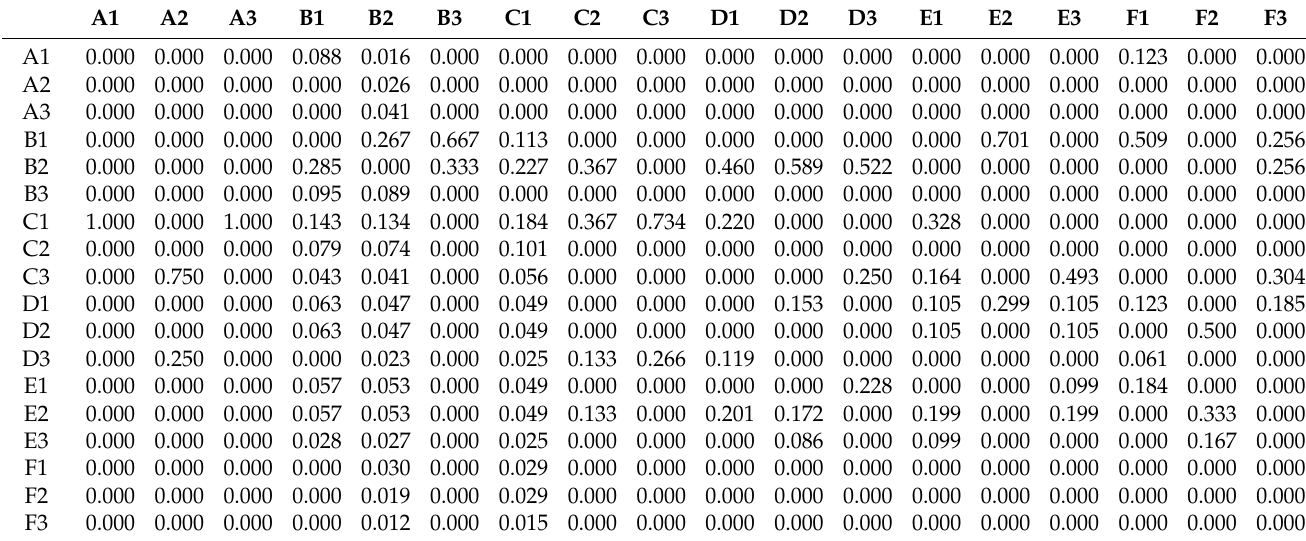
Table A3. The weighted